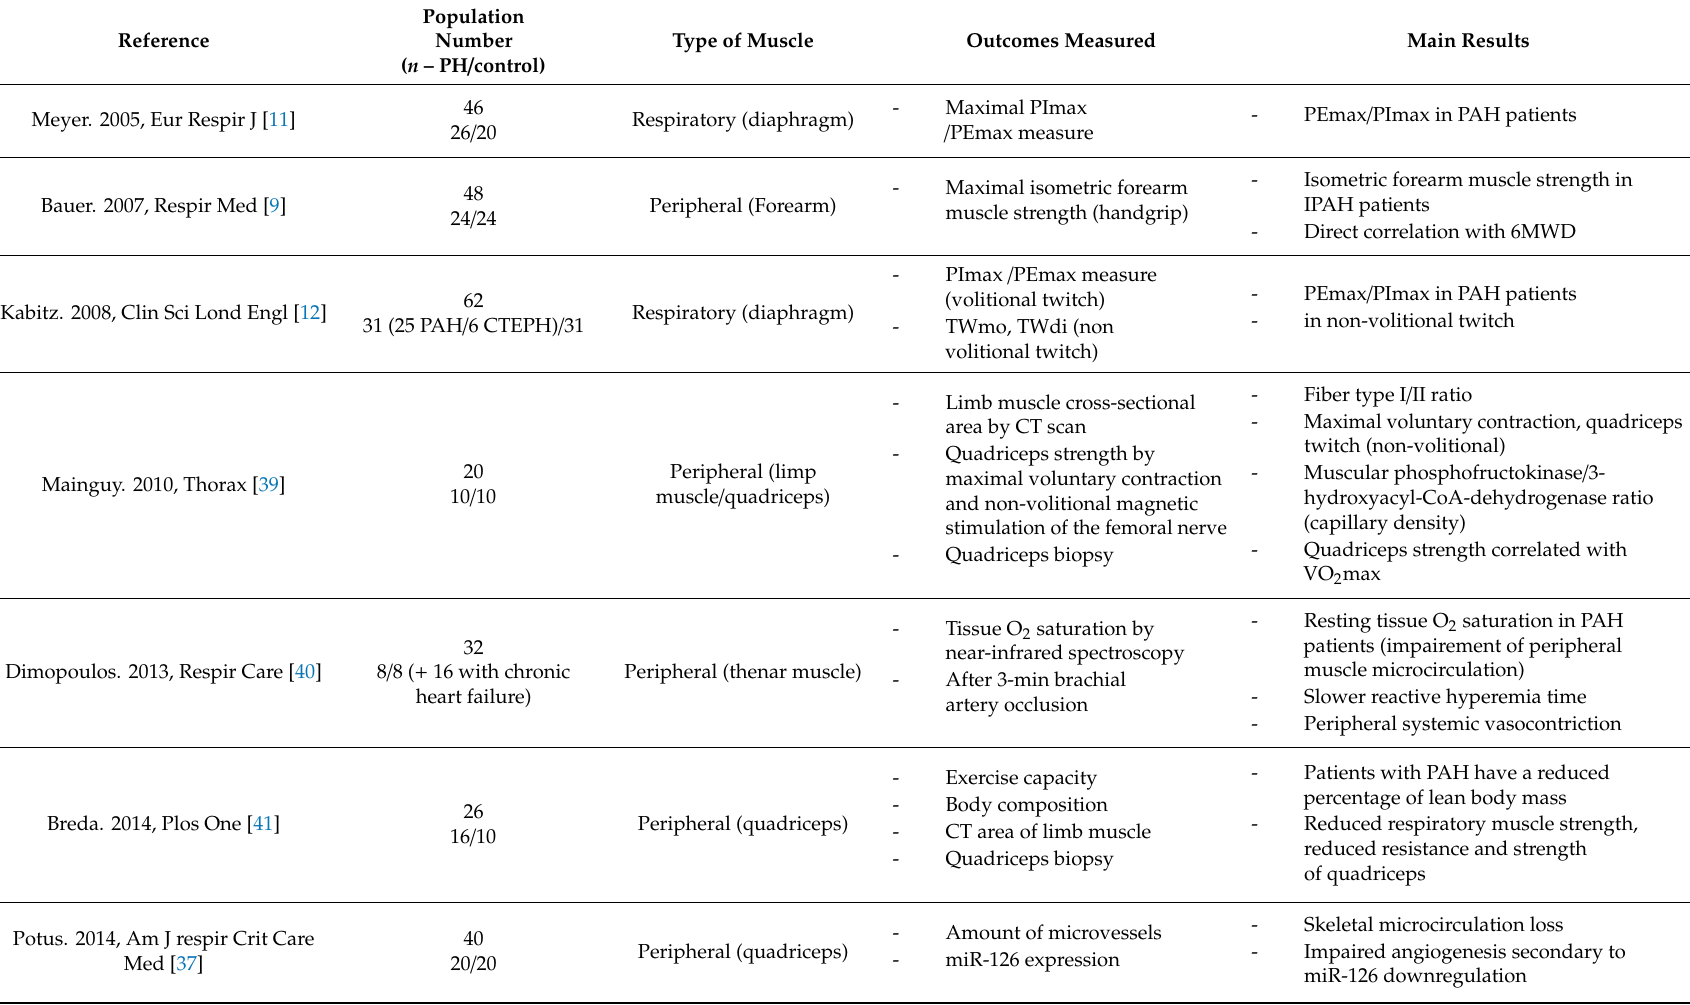
Table 2. Clinical data supporting pulmonary artery hypertension-related skeletal and respiratory muscles